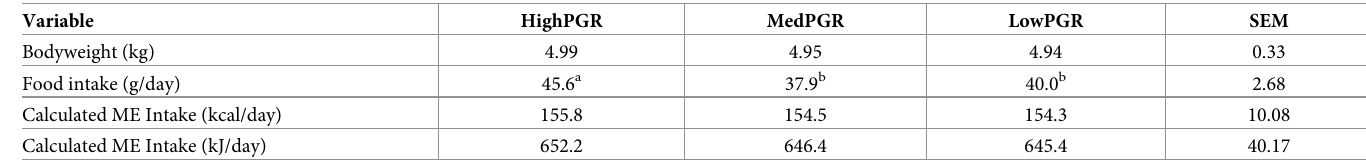
Table 2. Bodyweight, food and energy intake for cats (n = 19) consuming three commercial diets differing in PGR 1 .